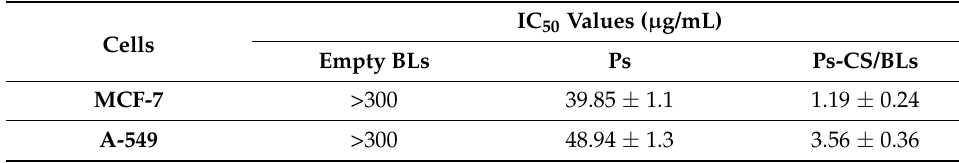
Table 3. IC 50 Values for empty bilosomes, Free Ps, and Ps-CS/BLs.